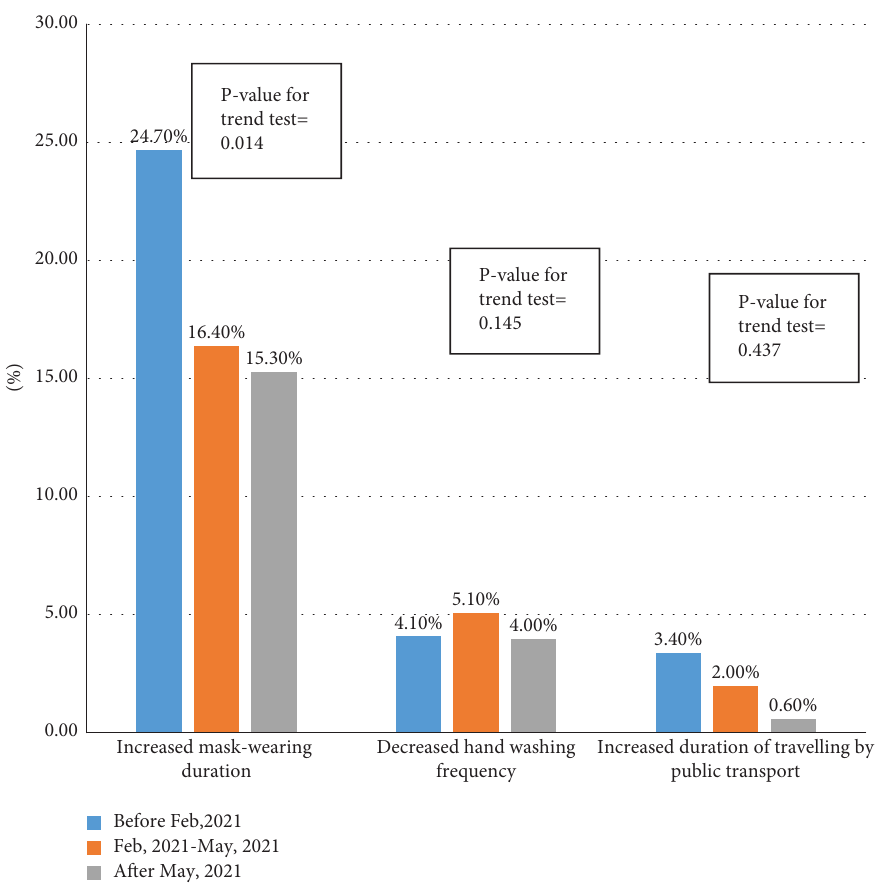
Figure 3: Association between time of frst dose of vaccination received and health behaviours.